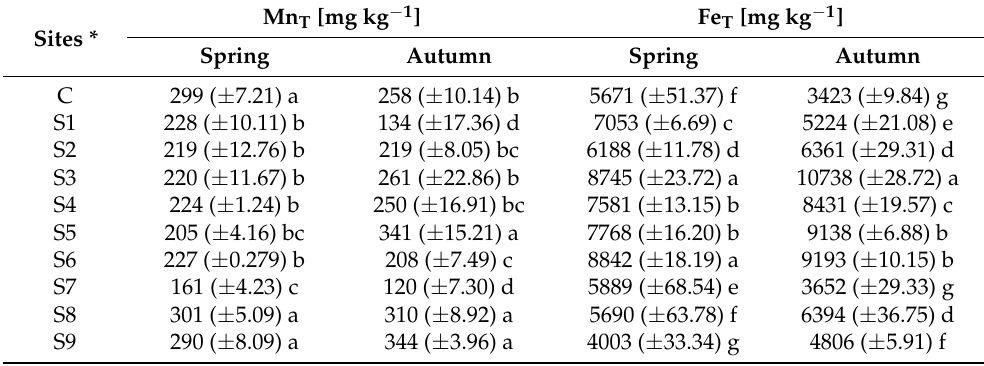
Table 3. Content of total manganese and iron in soil.